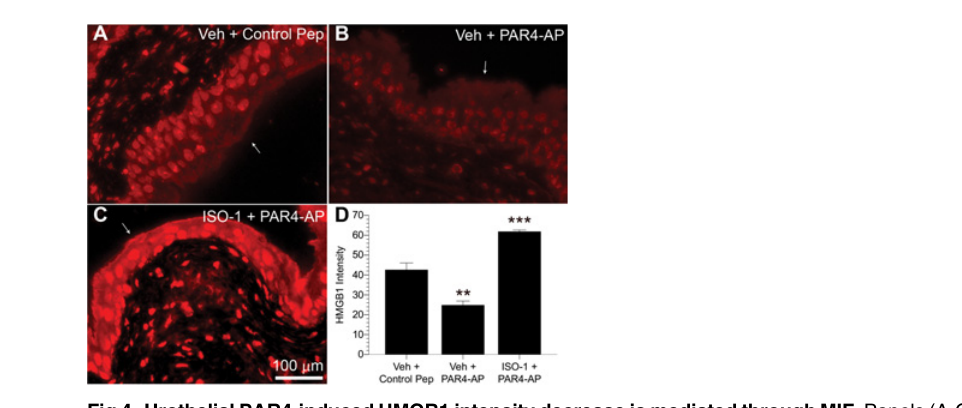
Fig 4. Urothelial PAR4-induced HMGB1 intensity decrease is mediated through MIF. Panels (A-C) show urothelial HMGB1 immunofluorescence 1 hour after intravesical exposure to control peptide, PAR4-AP, or PAR4-AP after pretreatment with MIF antagonist, ISO-1 (ip). White arrows identify the intravesical surface of the urothelium. Less urothelial HMGB1 immunofluorescent labeling is apparent in PAR4-AP exposed bladders (B) than in control peptide-treated bladders (A). Pretreatment with MIF-1 antagonist ISO-1 prevented this decrease (C). Quantitative image analysis (D) revealed that average urothelial HMGB1 immunofluorescence significantly decreased after intravesical PAR4-AP administration in comparison to control peptide-treated animals ( ** p (cid:1) 0.01), indicating urothelial release of HMGB1. In contrast,